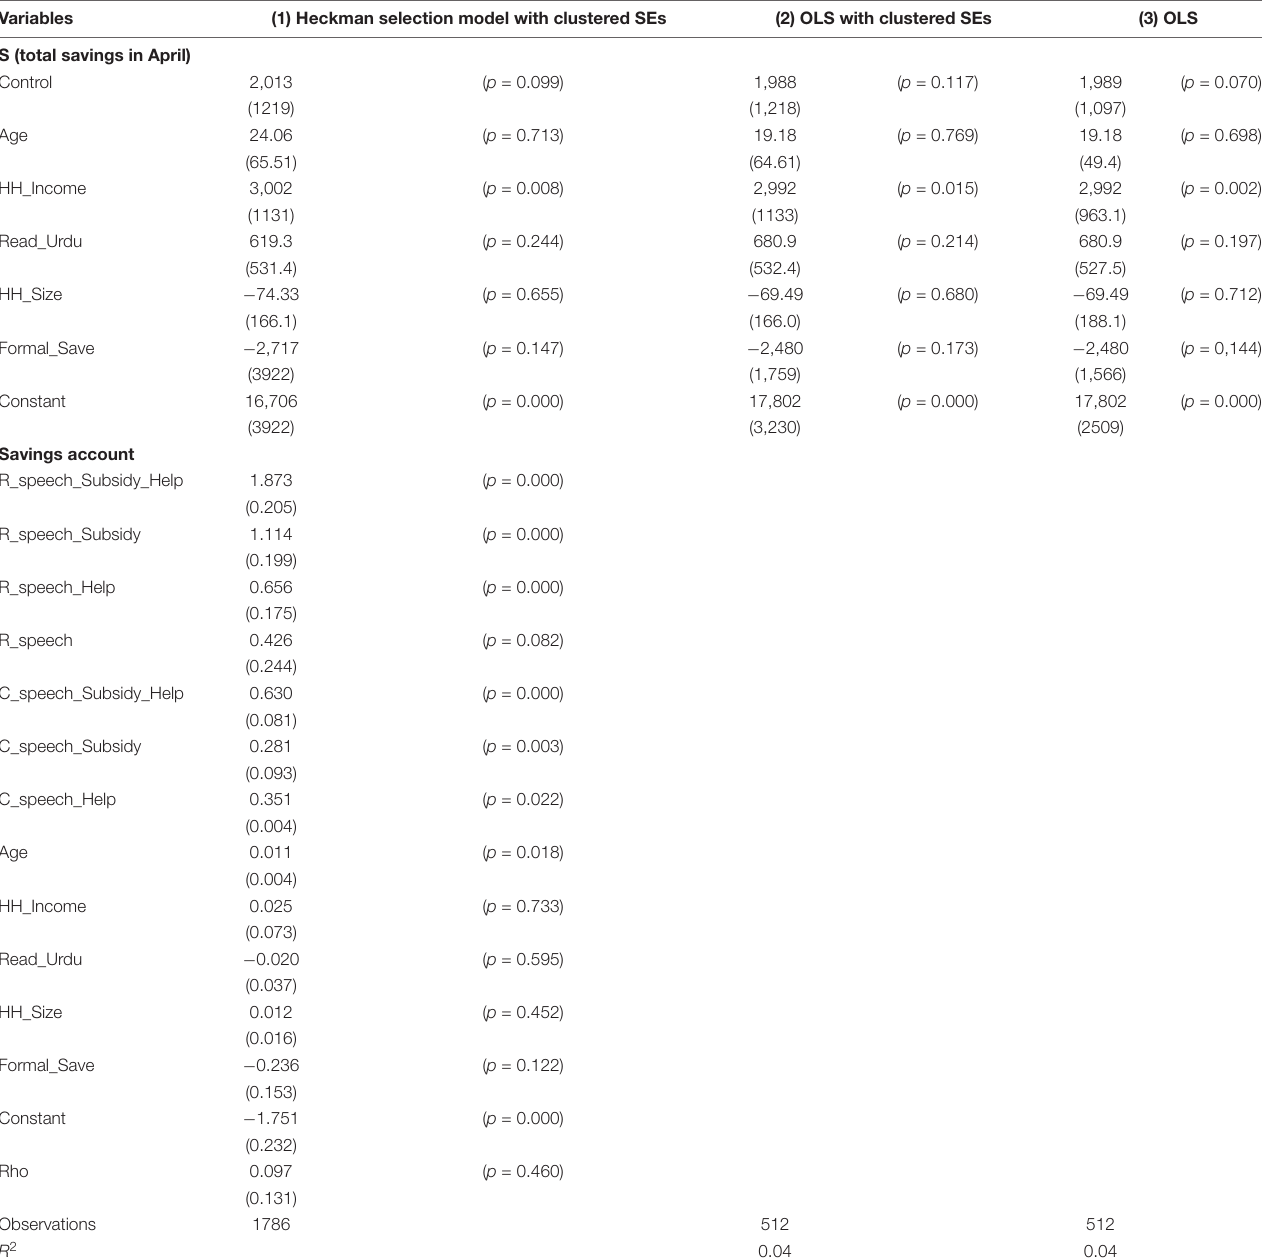
TABLE 4B | Robustness tests with total savings in April and